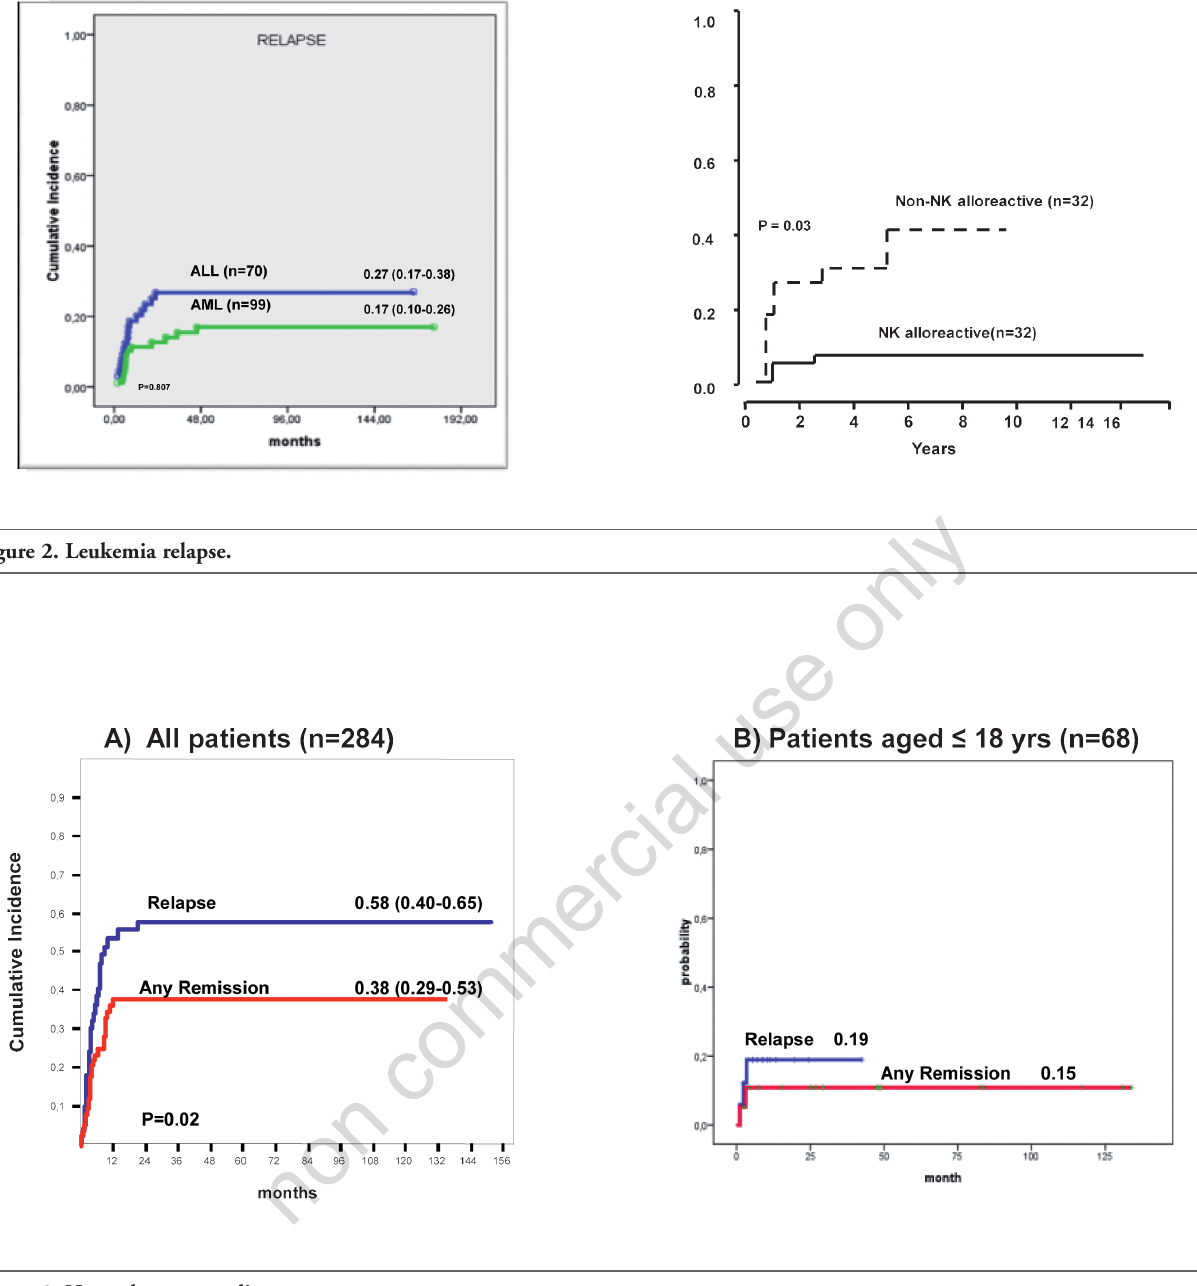
pacts strongly on outcomes in patients with AML in remission. 13